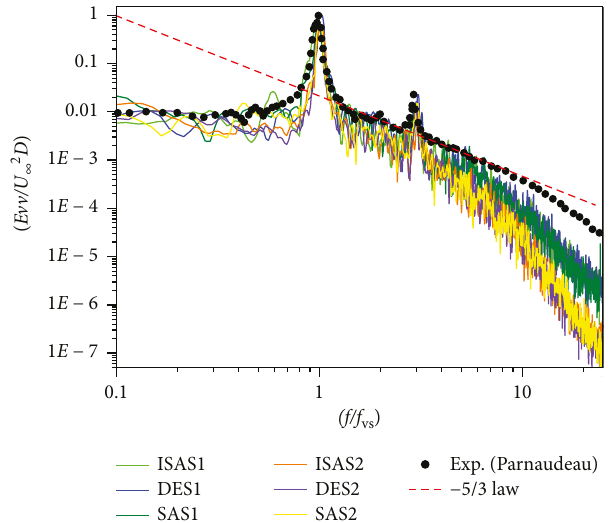
Figure 14: One-dimensional spectra of the transverse velocity at x / D